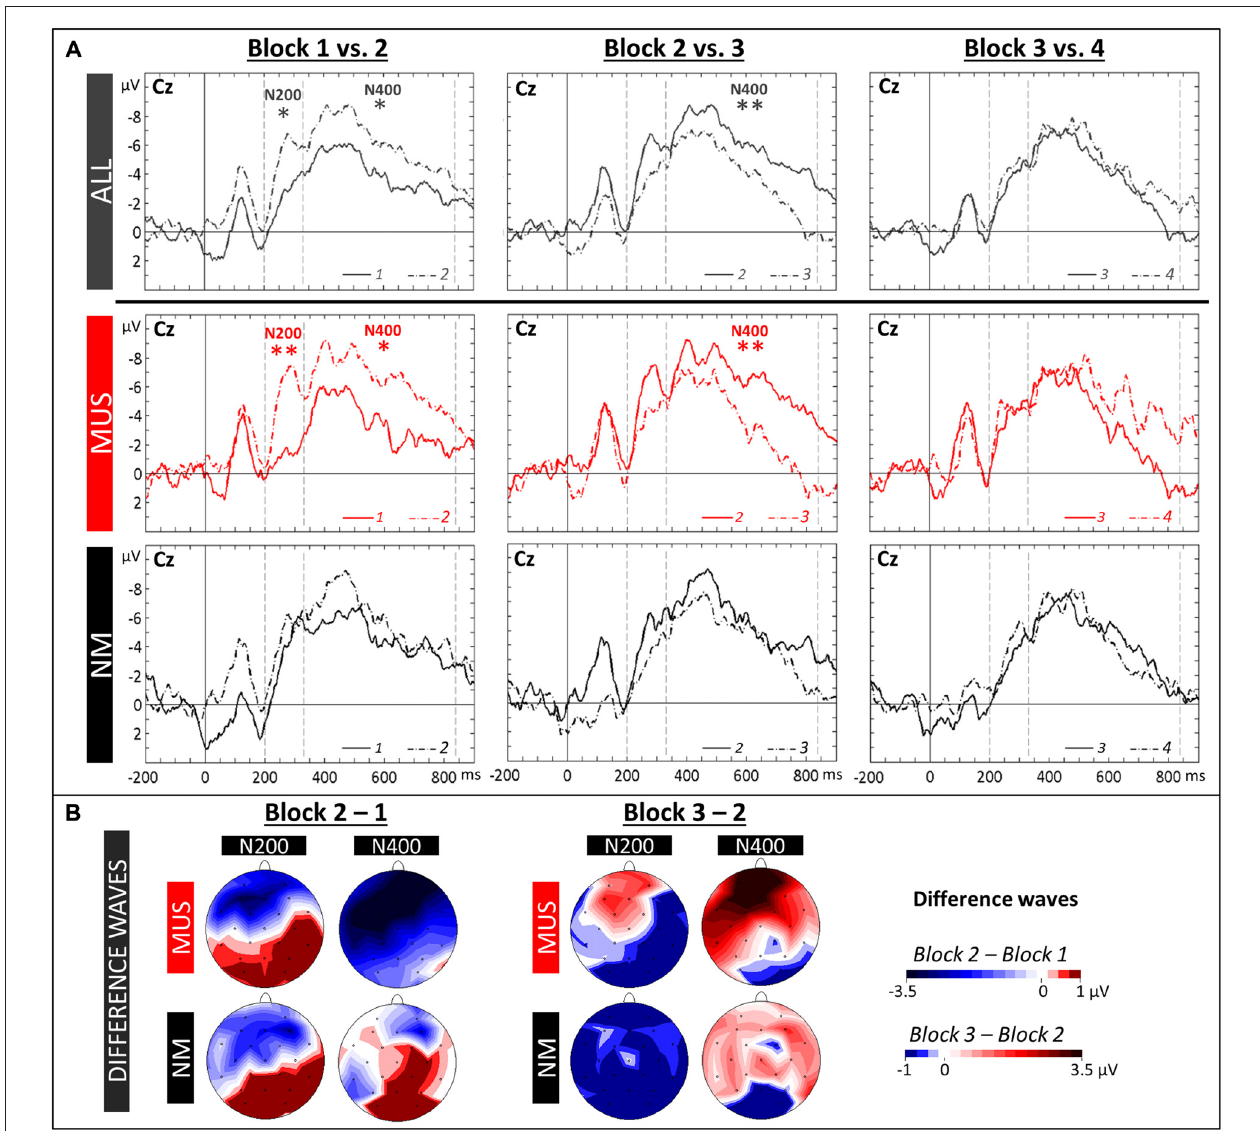
FIGURE 4 | Word learning phase 1. (A) ERPs recorded at the Central (Cz) electrode in the four Blocks are overlapped separately for Block 1 and 2 (left column), Block 2 and 3 (central column) and Block 3 and 4 (right column). Recordings are presented averaged across all children (ALL, dark gray lines) and for musician (MUS: red lines) and non-musician children (NM: black lines). Mean number of trials contributing to the averages (ALL = 607, MUS = 317, NM = 290). (B) Topographic voltage distribution maps of the differences between two blocks (2–1: Block 2 minus Block 1, and 3–2: Block 3 minus Block 2) are illustrated for the N200 and N400, separately for MUS and for NM. Voltage values are scaled from –3.5 µ V to +1.0 µ V and –1.0 µ V to +3.5 µ V,